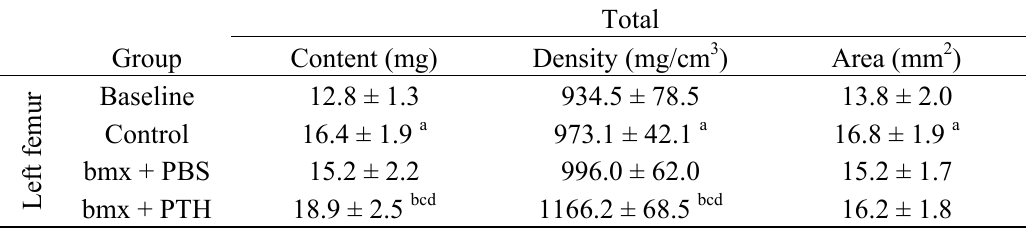
Table 2. Total content, density and area of right and left femurs as measured by pQCT. Data are presented as mean ± SD. a = p < 0.001 vs. Baseline; b = p < 0.001 vs. Control; c = p < 0.001 vs. Right femur; d = p < 0.001 vs. bmx + PTH. n = 8 for Control; n = 12 for all other